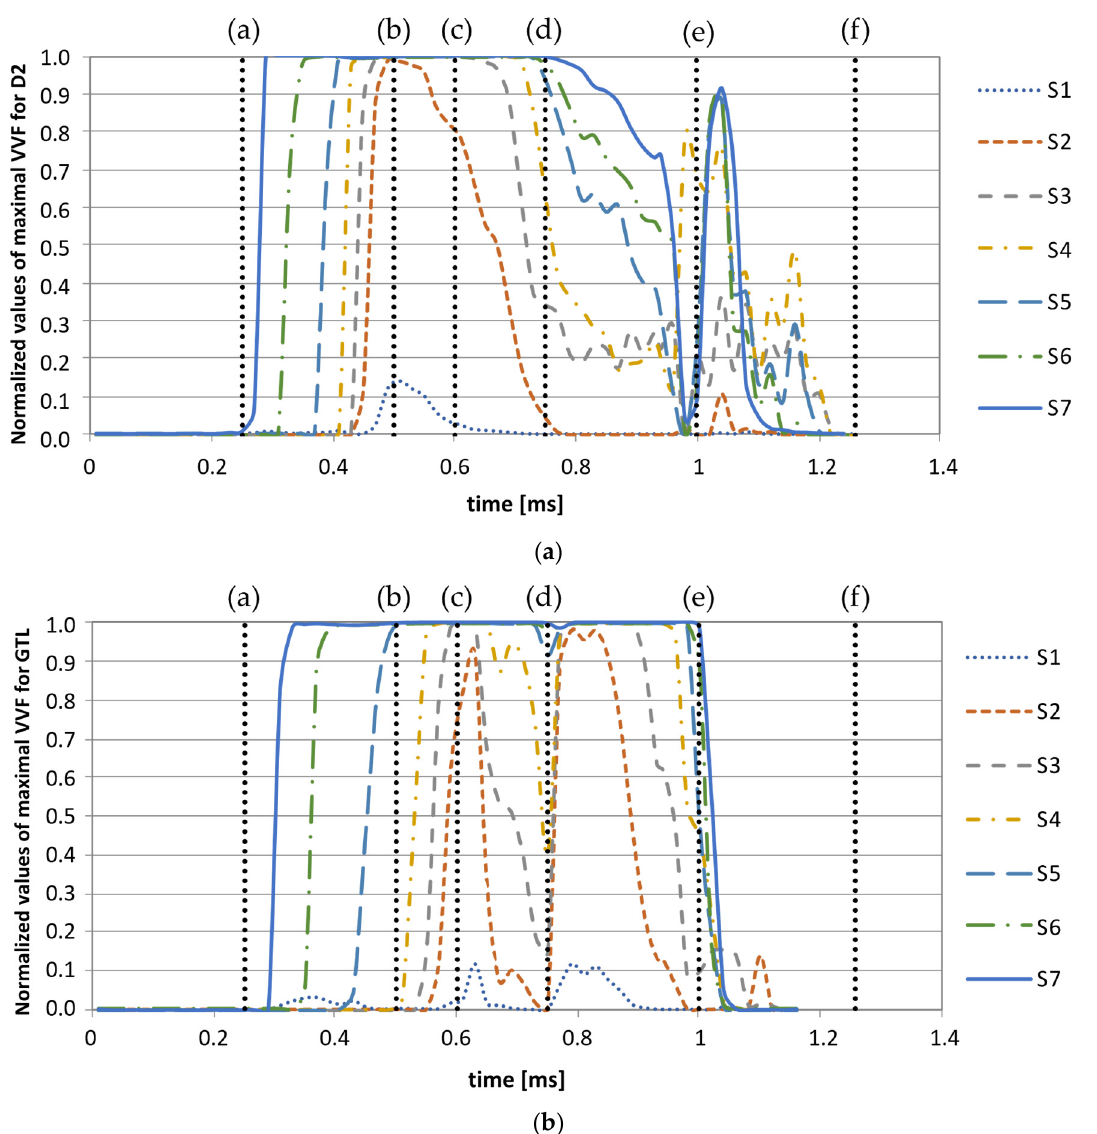
Figure 9. Volume fraction curved diagram at 60 bar of in-cylinder pressure, ( a ) with D2; ( b ) with